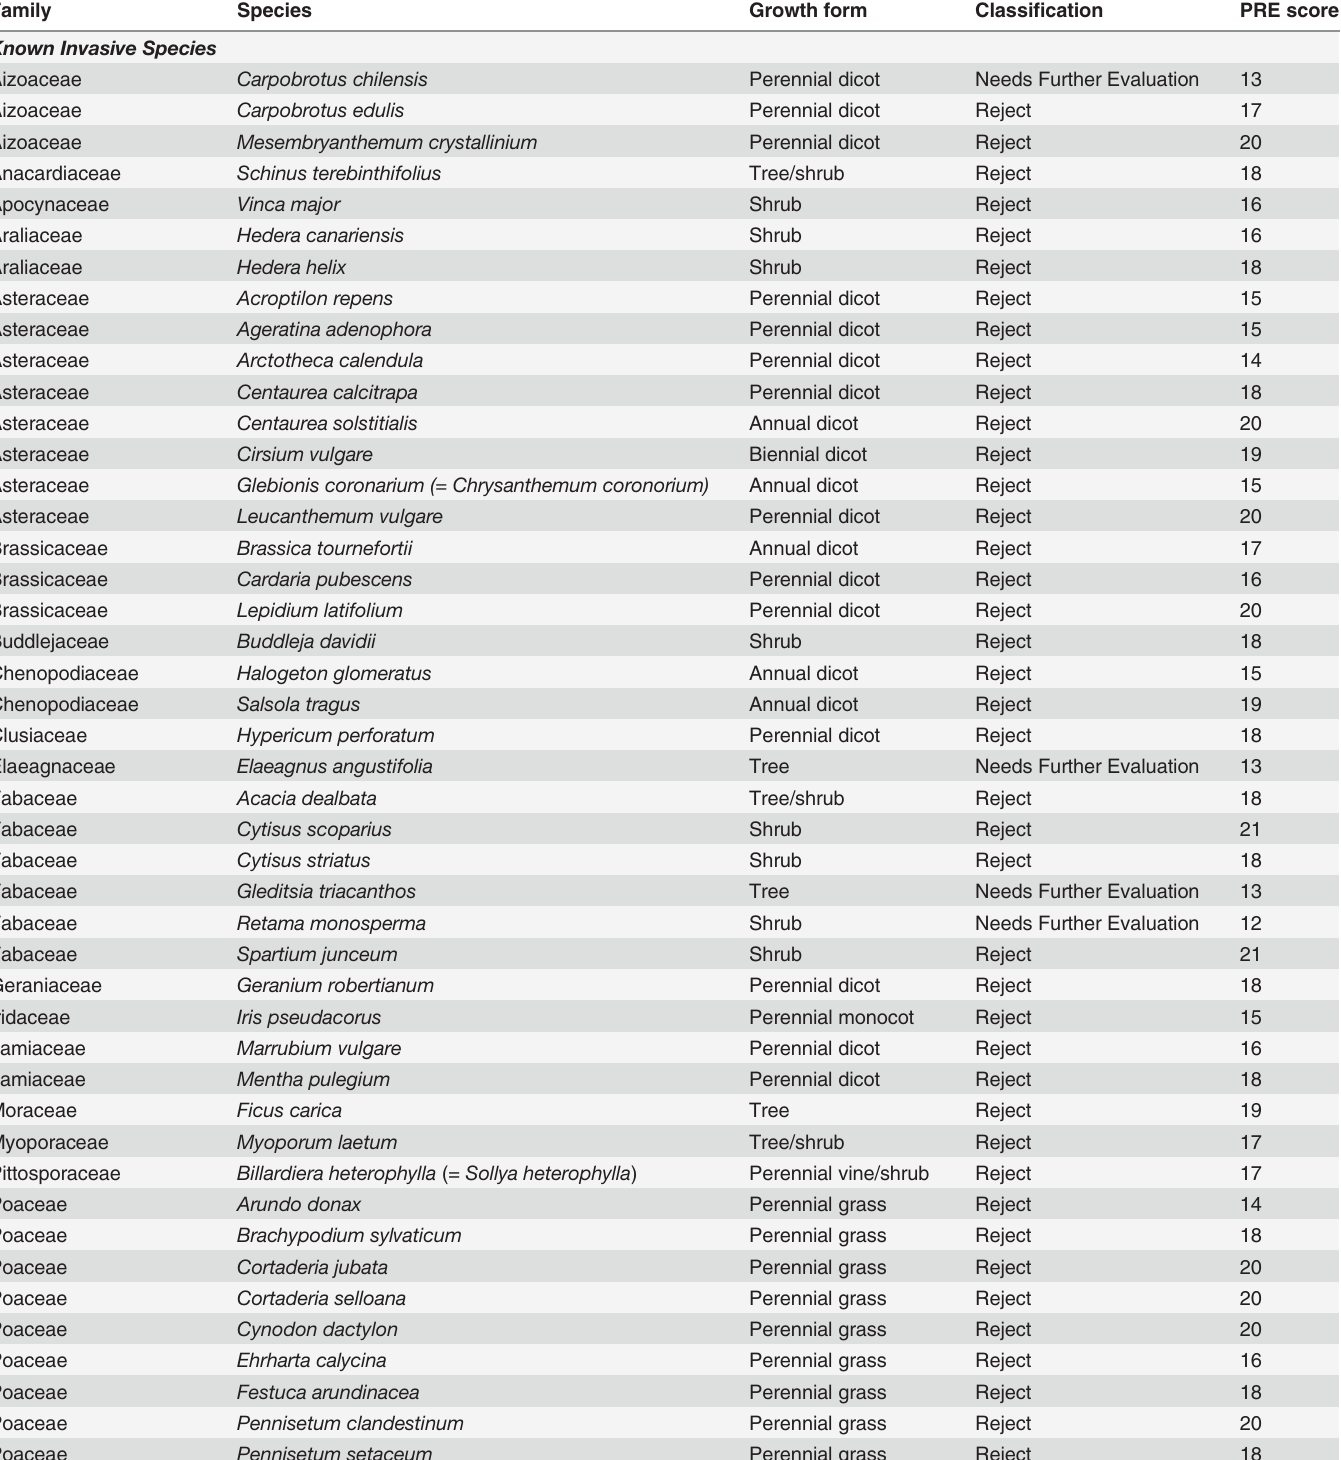
Table 3. Known invasive and non-invasive species evaluated with the PRE tool, including their scores and classification as either Reject, Needs Further Evaluation, or Accept.